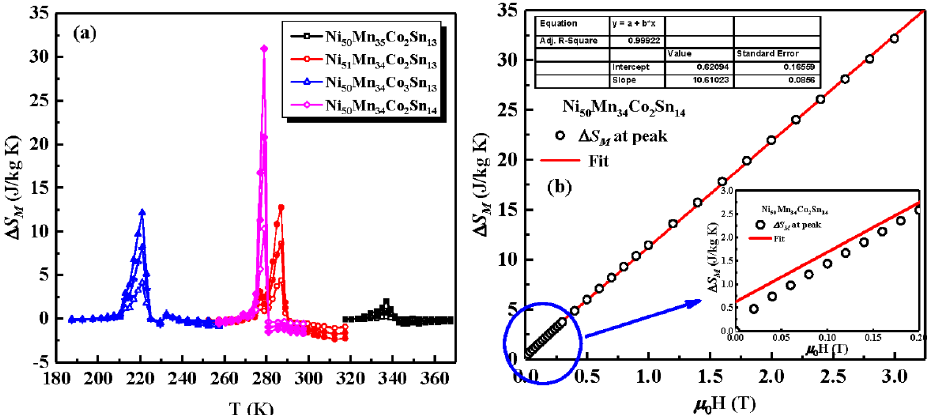
Figure 5. ( a ) Temperature dependence of ∆ S M for Ni-Mn-Co-Sn alloys under different magnetic field changes of 1 T, 2 T, and 3 T, respectively. ( b ) The maximum Δ S M as a function of μ 0 H and the fitting line to Δ S M - μ 0 H curve for Ni 50 Mn 34 Co 2 Sn 14 alloy. The inset shows the Δ S M - μ 0 H curve and the fitting line at low fields.